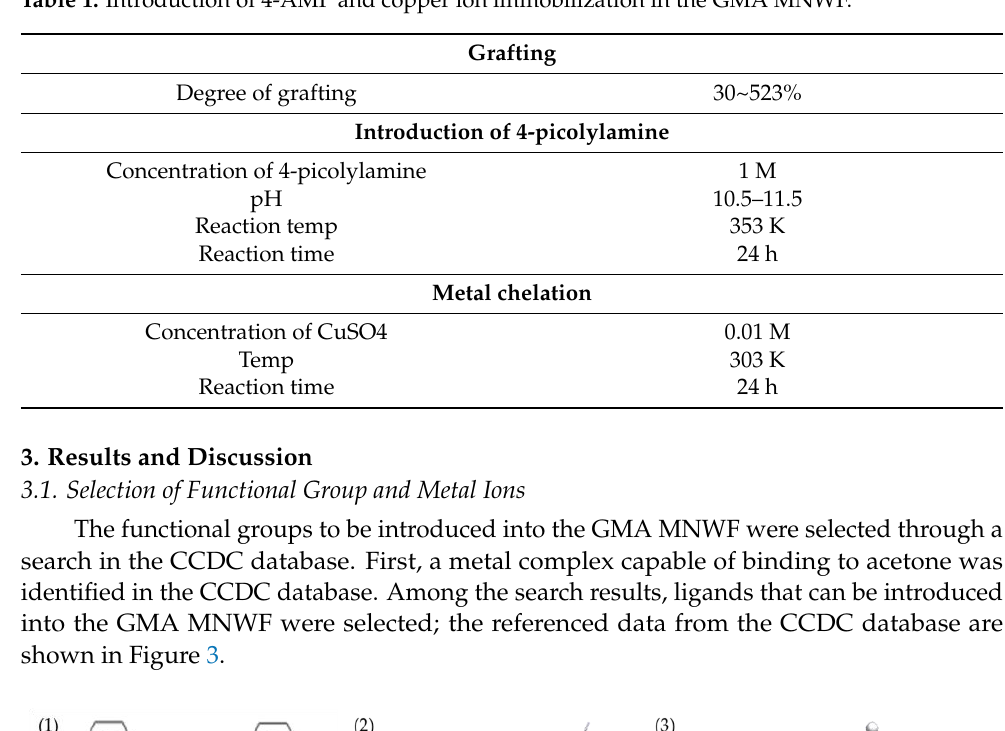
Table 1. Introduction of 4-AMP and copper ion immobilization in the GMA MNWF.